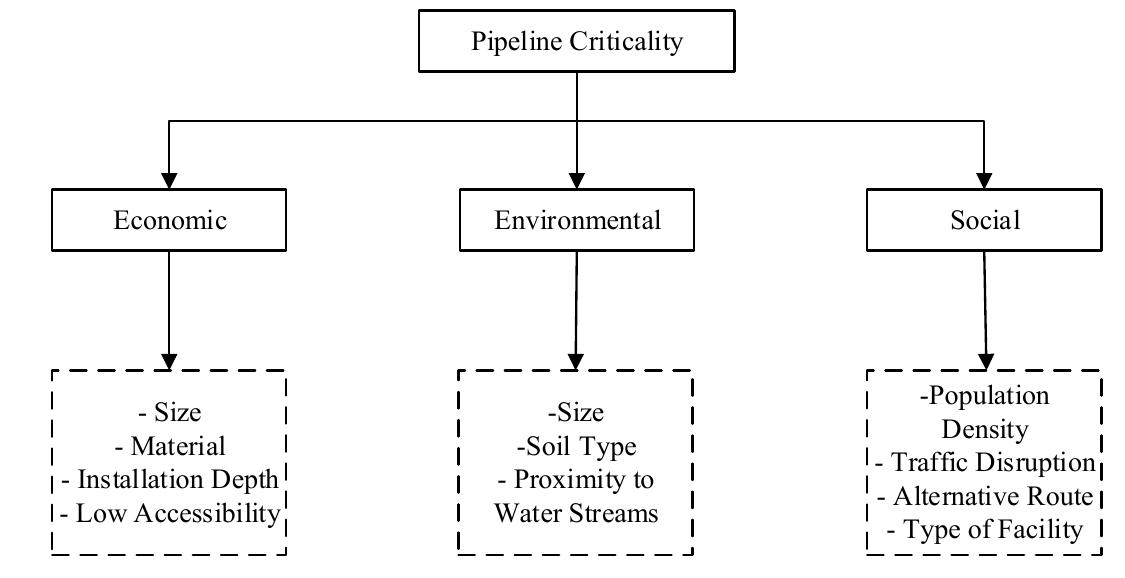
Figure 5. Criticality factors and